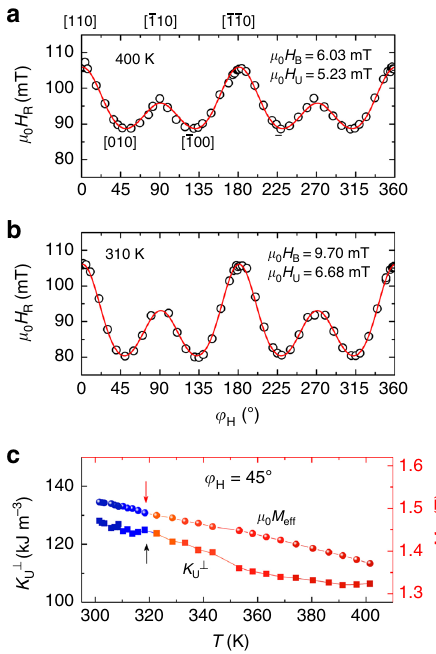
Fig. 4 Magnetic anisotropies of FeRh/Pt at different temperatures. a , b In-plane rotation angle φ H -dependent resonance fi eld of FeRh (10)/Pt at 11 GHz and at a 400 K and b 310 K. The data are fi tted (solid lines) to extract the magnetic anisotropy parameters. c Temperature dependence of μ 0 M eff (spheres) and K ? (squares) measured at φ H = 45° of FeRh (10)/Pt during U cooling into the phase transition region (blue spheres and squares). The error bars, which are standard deviations obtained from the fi t, are smaller than the size of the